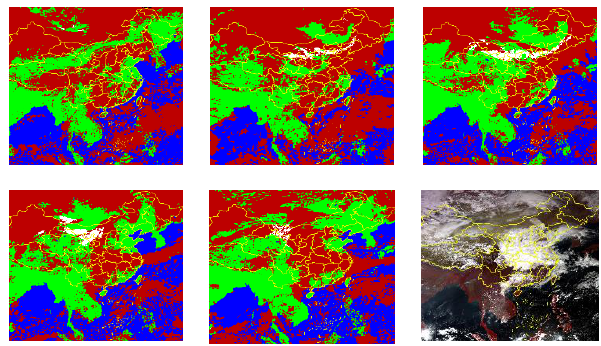
03:00, 05:00, 07:00 UTC on May 5, 2016, 190, 123, and 155